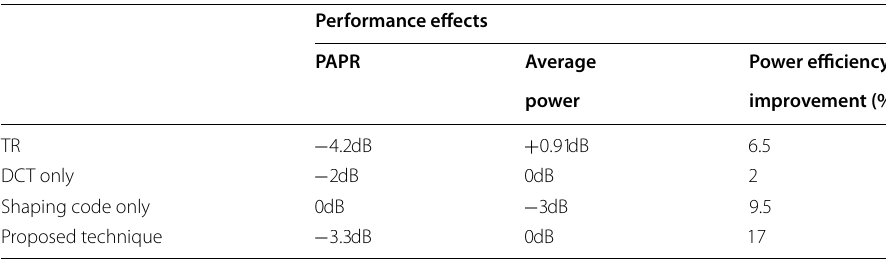
Table 6 Comparative study